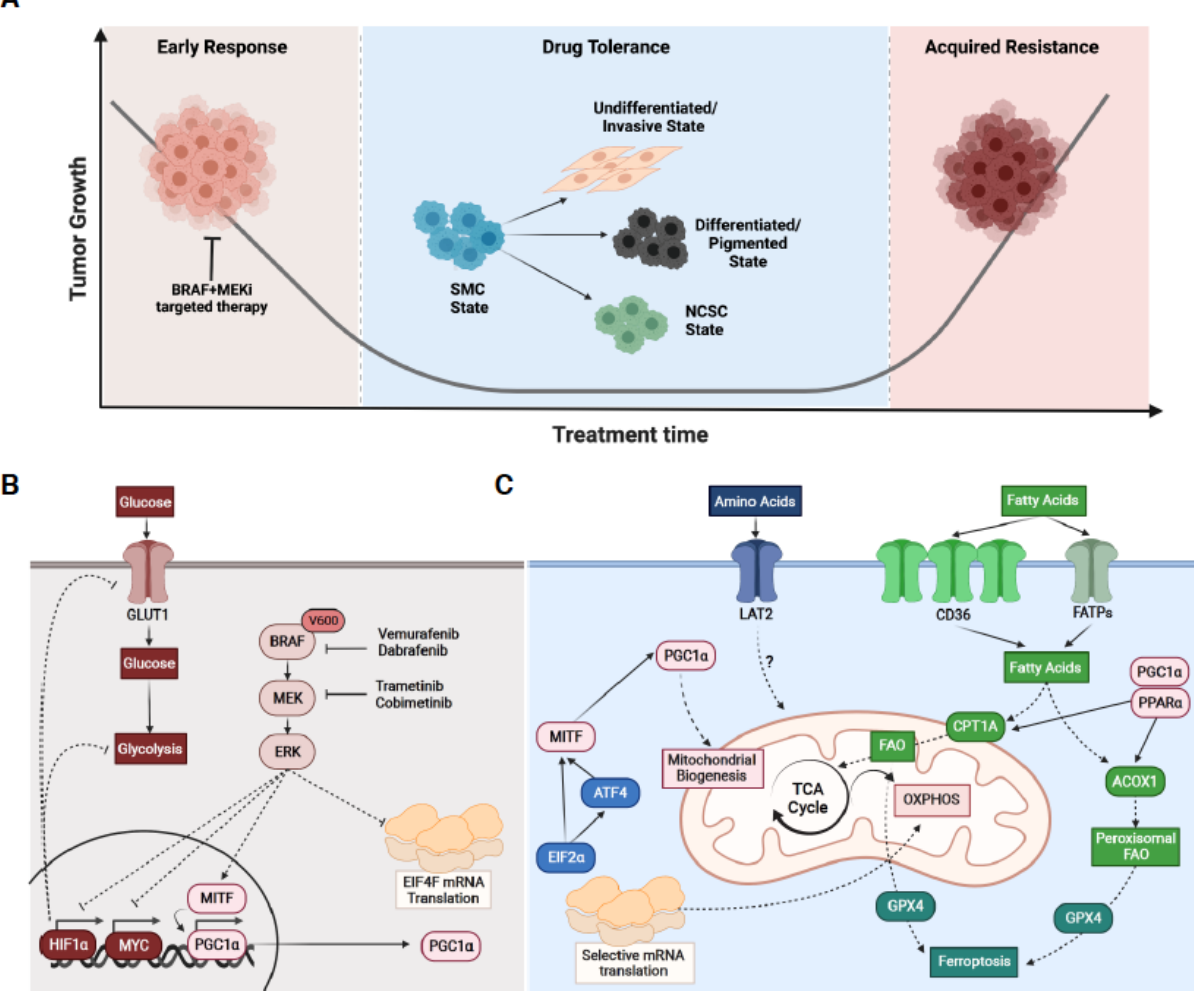
Figure 2. Metabolic plasticity and the targeted therapy response. ( A ) Schematic of the major phases of the targeted therapy response in BRAF V600 melanoma cells showing the emergence of distinct drug tolerant cell populations that subsequently give rise to acquired resistance (BRAF+MEKi = BRAF and MEK inhibitor; SMC = starved-like melanoma cell; NCSC = neural crest stem cell). ( B ) Schematic showing the major metabolic pathways regulated after initial exposure to tar- geted therapies, involving suppression of hypoxia-inducible factor 1-alpha (HIF1 α ) and c-Myc (MYC) mediated glycolysis, and activation of the master regulator of oxidative metabolism peroxisome proliferator-activated receptor γ coactivator α (PGC1 α ). Concurrently, eukaryotic initiation factor 4F (EIF4F)-mediated global translation is suppressed. See text for details. ( C ) Schematic showing the major metabolic pathways regulated during drug tolerance in melanoma cells following exposure to MAPK targeted therapies. Activation of PGC1 α leads to mitochondrial biogenesis and elevated oxidative phosphorylation (OXPHOS). Activation of eukaryotic initiation factor 2 alpha (EIF2 α ) and activating transcription factor 4 (ATF4) lead to se- lective translation programs that regulate microphthalmia-associated transcription factor (MITF) and subsequently impinge on PGC1 α mediated mitochondrial metabolism and cellular invasion. Fatty acid transporters are also upregulated and facilitate carnitine palmitoyltransferase 1A (CPT1A)-dependent fatty acid oxidation (FAO) in the mitochondria and acyl-CoA oxidase 1 (ACOX1) dependent FAO in peroxisomes. Elevated FAO leads to increased dependency on glutathione peroxidase 4 (GPX4) mediated ferroptosis. See text for details. BRAF = BRAF protein; MEK = Mitogen-activated protein/extracellular signal-regulated kinase kinase; ERK = mitogen-activated protein/extracellular signal-regulated kinase; GLUT1 = glucose transporter 1; CD36 = cluster of differentiation 36; FATPs = fatty acid transporter proteins; PPAR α = peroxisome proliferator activated receptor alpha; TCA = tricarboxylic acid cycle. Created with